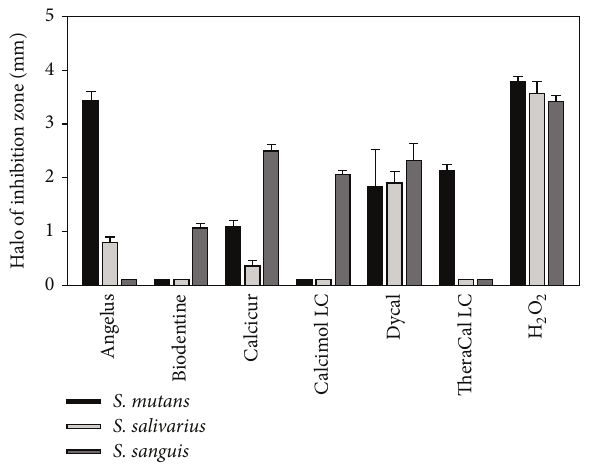
Figure 2: MDPC-23 cells cytocompatibility of the different pulp- capping materials using the Transwell method. MDPC-23 cells were incubated with the different pulp-capping materials at 37 ∘ C for 24 h, 48 h, and 72 h in a Transwell culture plate as reported in Materials and Methods Section. The cell viability was assessed with MMT test. The data are presented as percent of the control incubated in absence of any materials and set as 100%. Five replicates for each pulp-capping material were used for each experiment performed in duplicate. Error bars indicate standard errors of the